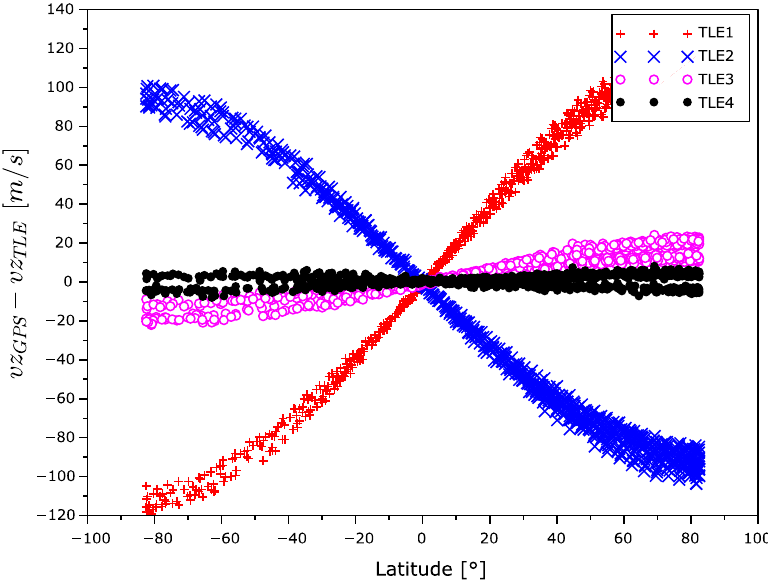
Figure 17. z coordinate velocity error as a function of